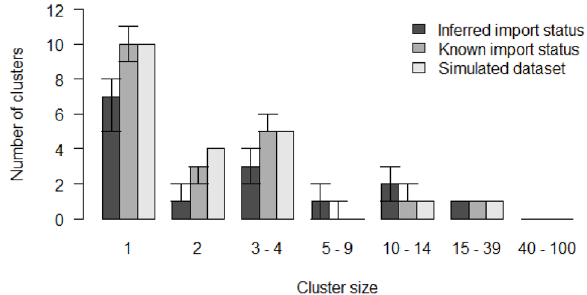
Figure 3. Comparison of inferred cluster size distribution in both models with the reference